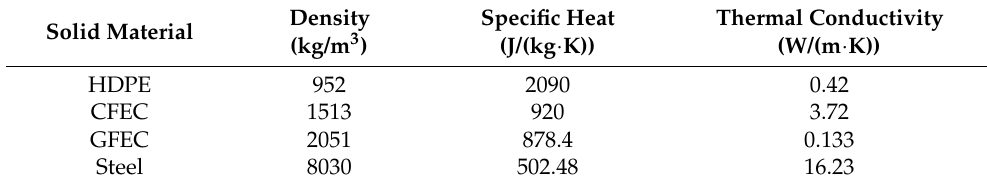
Figure 1. Two-dimensional geometry and computational grid of the cylinder before and after optimization (dimensions are given in millimeters): ( a ) Original scheme, ( b ) Optimized scheme. Table 1. Hydrogen storage cylinder material properties [21].